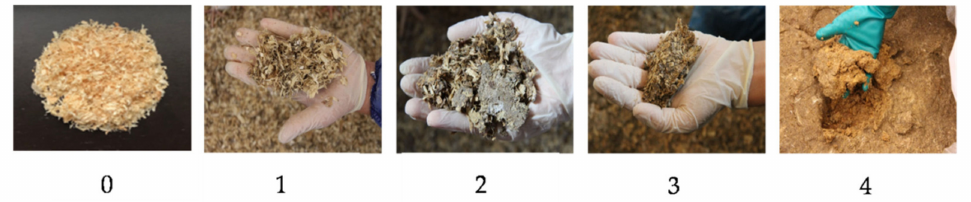
Figure 3. Illustration of the scores used during the litter quality